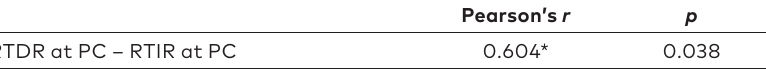
Table 2. Correlation between road traffic death and injury rates at pedestrian crossings Pearson’s r p RTDR at PC – RTIR at PC 0.604*